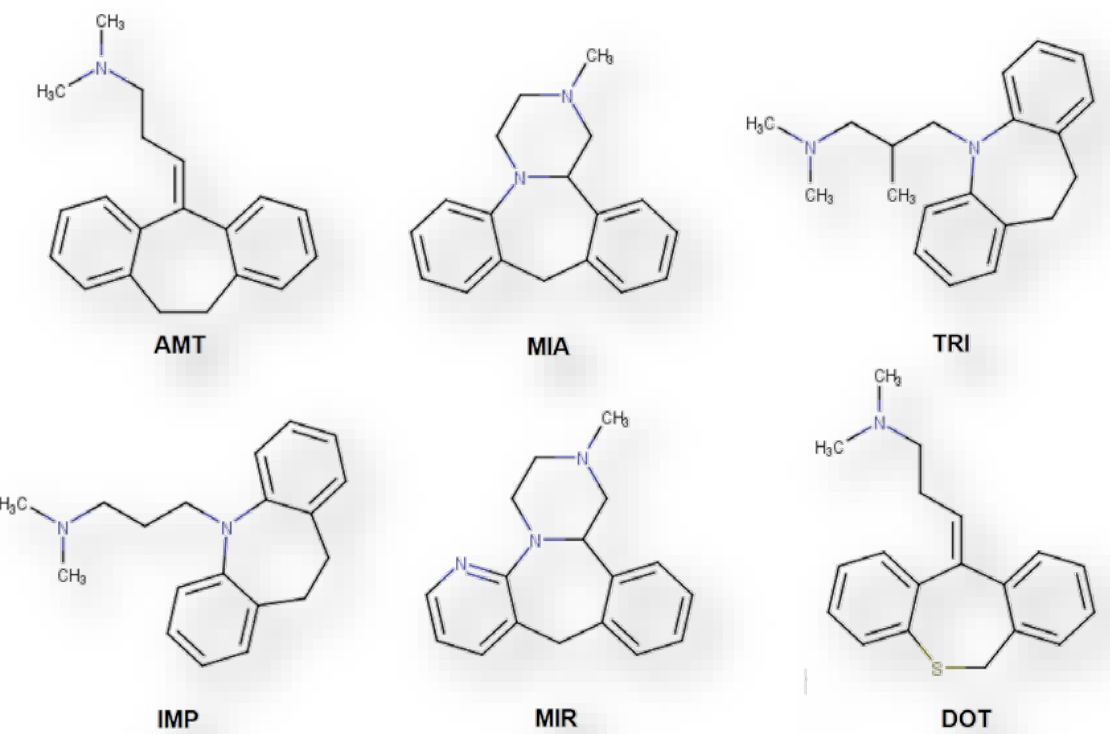
Figure 1. Chemical structures of the six TCAs studied in the present work.